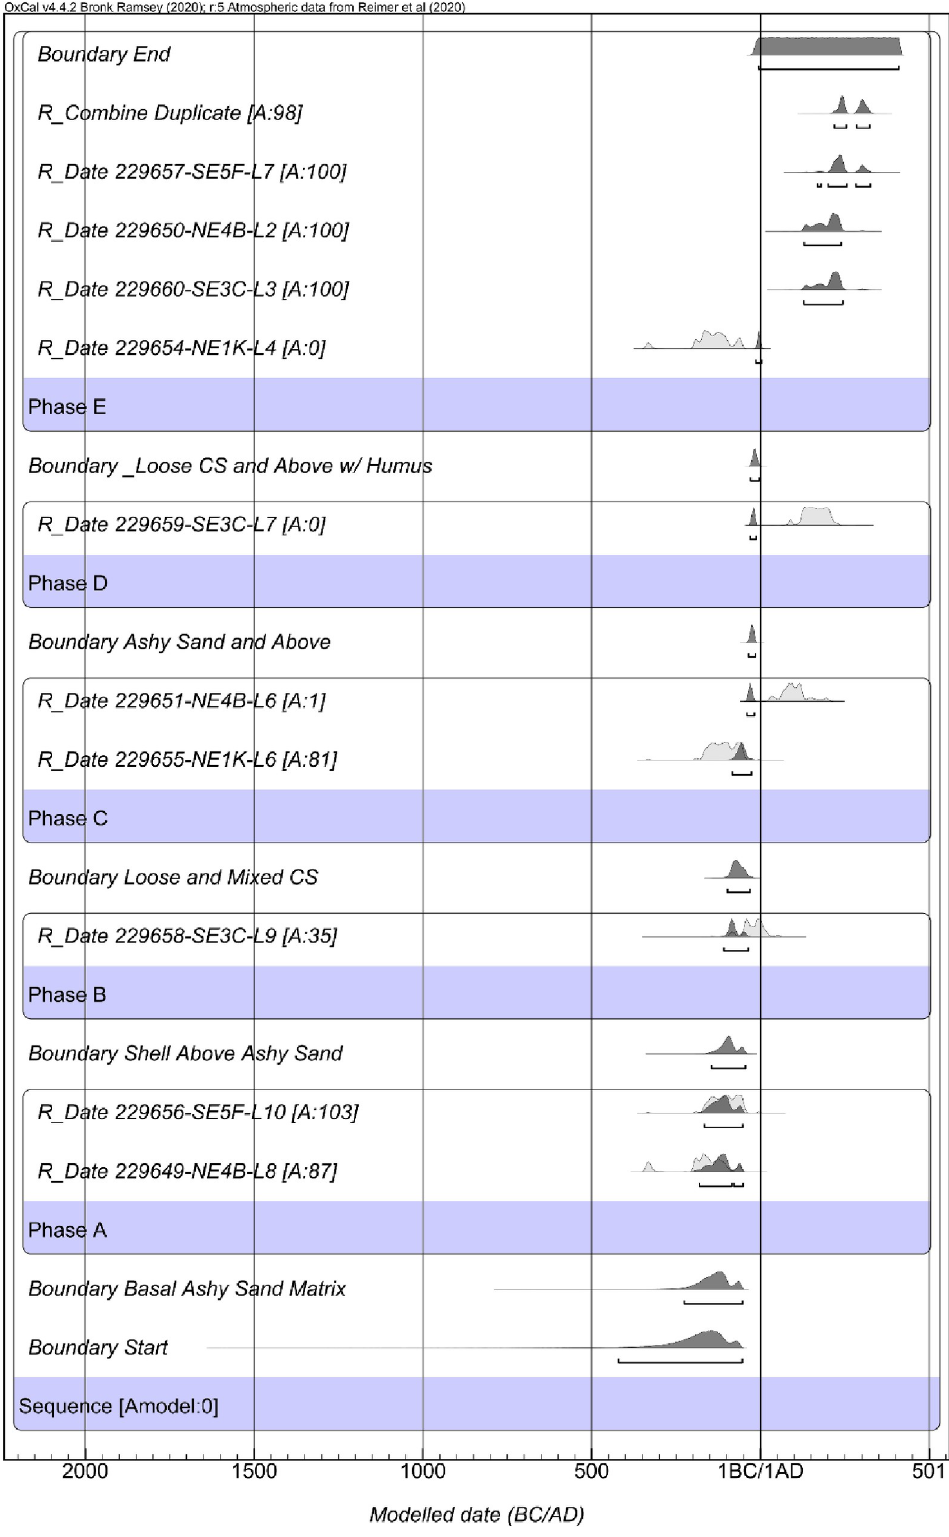
Fig 8. Results of the second iteration of the Palmrose chronological modeling.